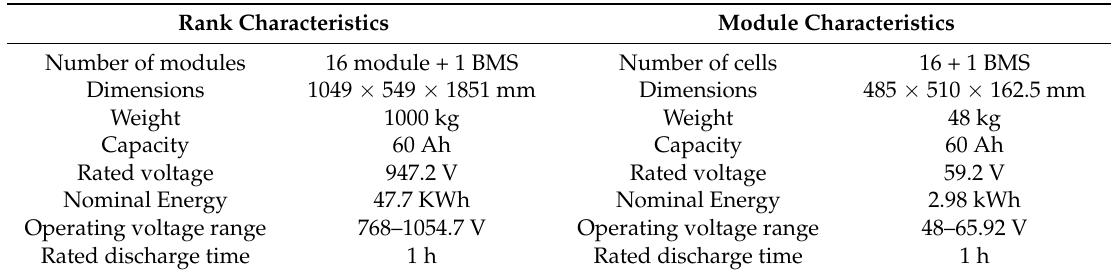
Table 1. Electrical characteristics of the tested technology.